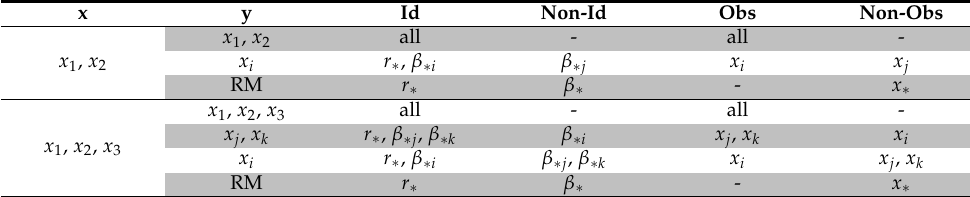
Table 1. gLV. Results for the generalized Lotka–Volterra models.